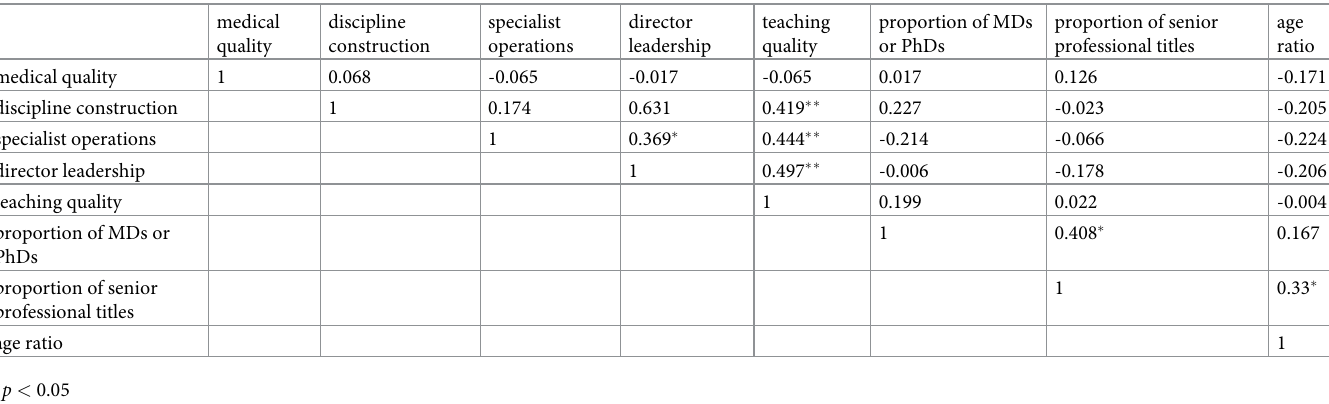
Table 5. Correlations coefficient matrix between variables.